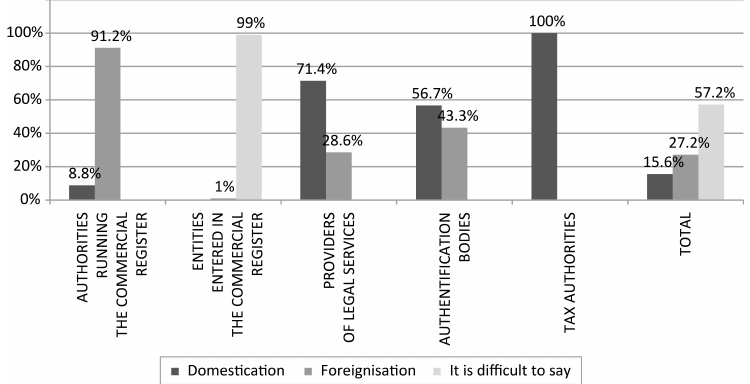
Figure 3. Distribution of the translation strategies in relation to the categories